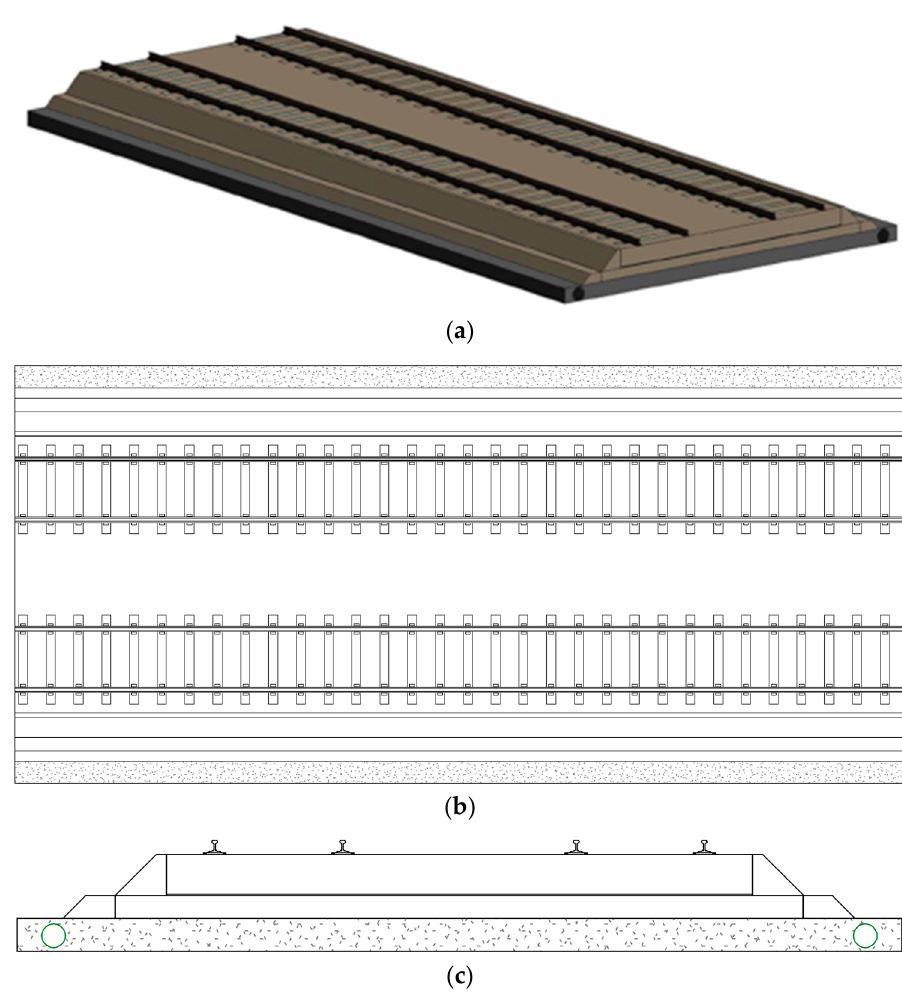
Figure 6. 3D model of the complete rail track including drainage created in Revit®: ( a ) perspective representation of the global 3D model; ( b ) plan representation of the model; and ( c ) the representation of the cross-section of the total rail track structure and lateral drainage pipes.